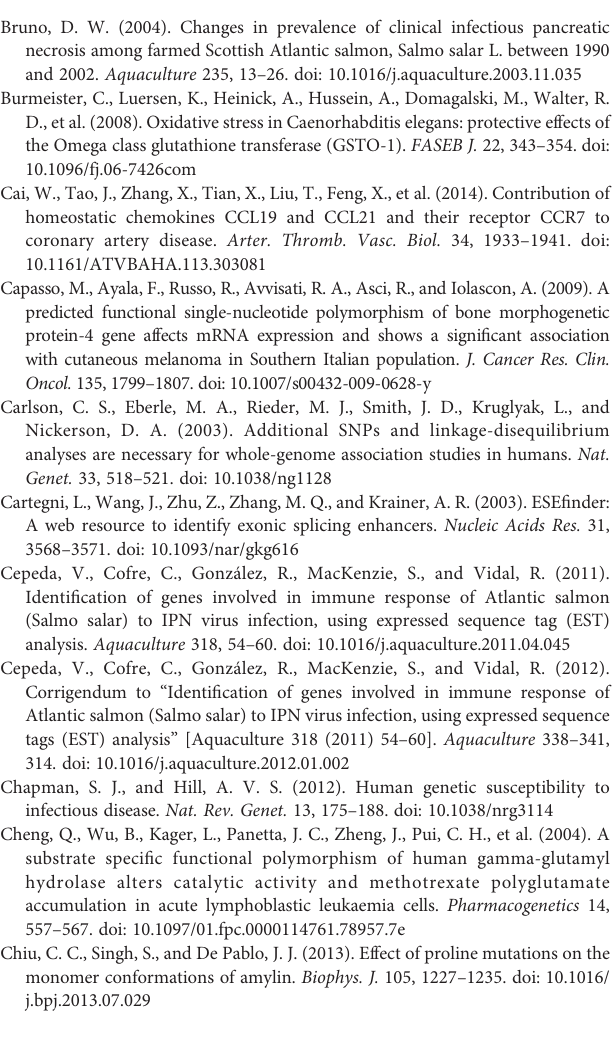
FIGURE S1 | Homology modeling for predicted S. salar CCL19 based on tridimensional H. sapiens CCL19 structure. (A) Tridimensional H. sapiens CCL19 (hCCL19) structure. (B) Predicted tridimensional S. salar CCL19 (sCCL19) structure. (C) hCCL19 and sCCL19 overlay. (D) Ramachandran plot for the predicted sCCL19 structure. The amino acid distribution into most favored regions (A,B,L), additional allowed regions (a,b,l,p), generously allowed regions (~a,~b,~l,~p) is indicated. FIGURE S2 | Homology modeling for predicted S. salar ITB2 based on tridimensional H. sapiens ITB2 structure. (A) Tridimensional H. sapiens ITB2 (hITB2) structure. (B) Predictedtridimensional S. salar ITB2(sITB2)structure. (C) hITB2and sITB2 overlay. (D) Ramachandran plot for the predicted sITB2 structure. The amino acid distribution into most favored regions (A,B,L), additional allowed regions (a,b,l, p), generously allowed regions (~a,~b,~l,~p) is represented. FIGURE S3 | Homology modeling for predicted S. salar HSP70 based on tridimensional H. sapiens HSP70 structure. (A) Tridimensional H. sapiens HSP70